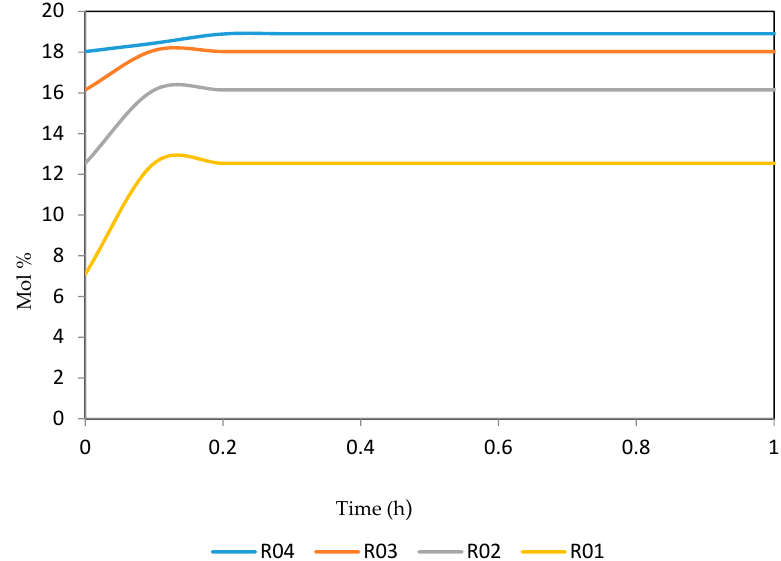
Figure 27. Dynamic behaviour of A 7 in the four reactors.